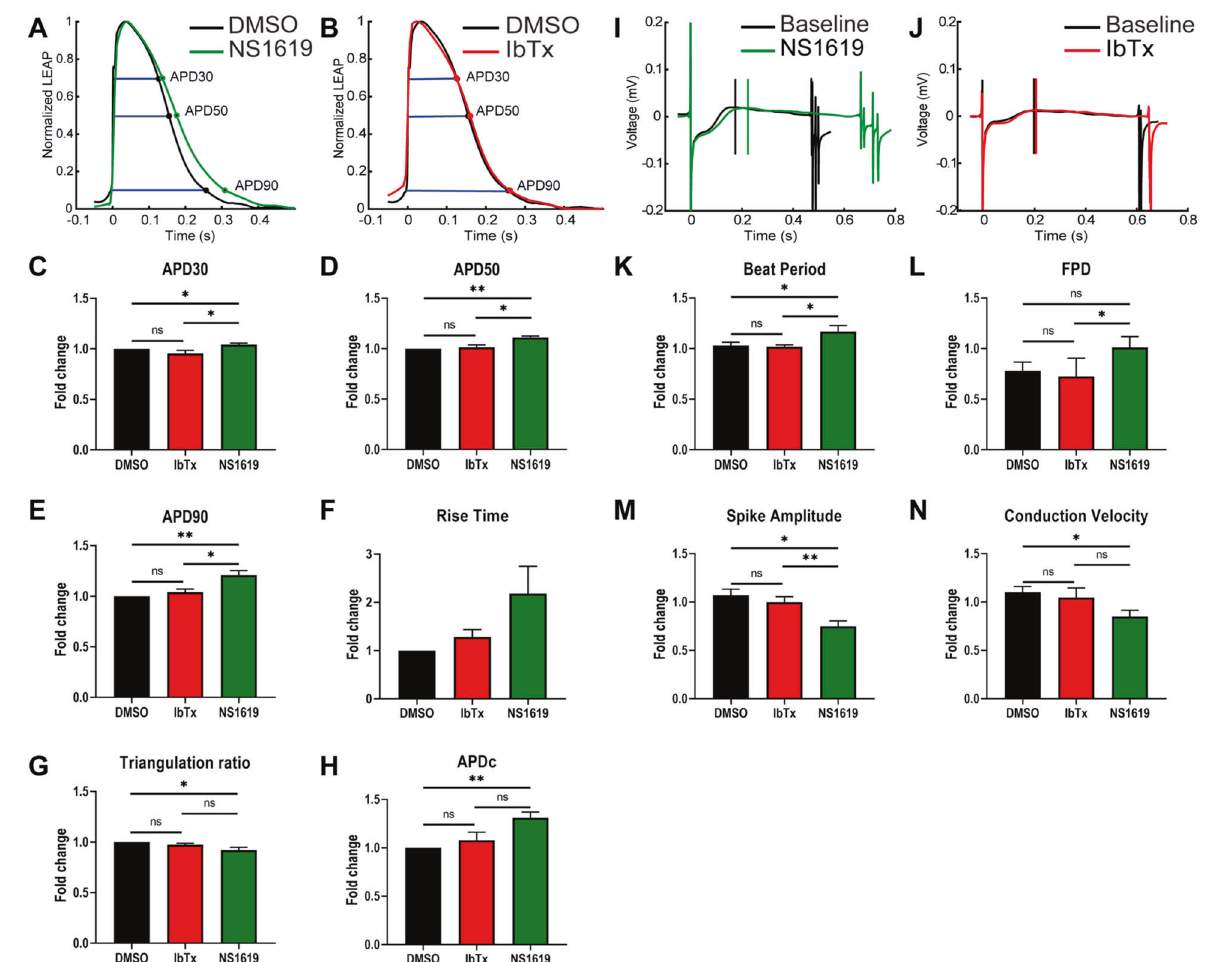
Fig. 7 Functional analysis of activation and inhibition BK Ca channel in p3 neonatal cardiomyocytes on multi-electrode array (MEA) systems. Rat neonatal cardiomyocytes plated on classic MEA 24-well plates containing electrodes were dosed with DMSO, NS1619, or IbTX. Normalized LEAP waveforms for NS1619 ( A ; green trace) and IbTx ( B ; red trace) were overlaid with DMSO control (black trace). Bar plots represent C APD30, D APD50, E APD90, F rise time, G triangulation ratio, and H APDc for IbTX and NS1619 normalized to DMSO group and represented as fold-change mean ± SEM. Field potential duration waveform ( I , J of neonatal cardiomyocytes post-treatment with NS1619 ( I ; green trace), and IbTx ( J ; red trace) overlaid with their respective pre-treatment baseline electrodes. Bar plots represent K beat period, L fi eld potential duration, M spike amplitude, and N conduction velocity for DMSO, IbTx, and NS1619 were normalized to their respective pre- treatment electrodes and represented as fold-change mean ± SEM from three independent littles. P -values were determined by a one-tailed paired student ’ s t -test; ns is not signi fi cant, * ≤ 0.05, ** ≤ 0.001.